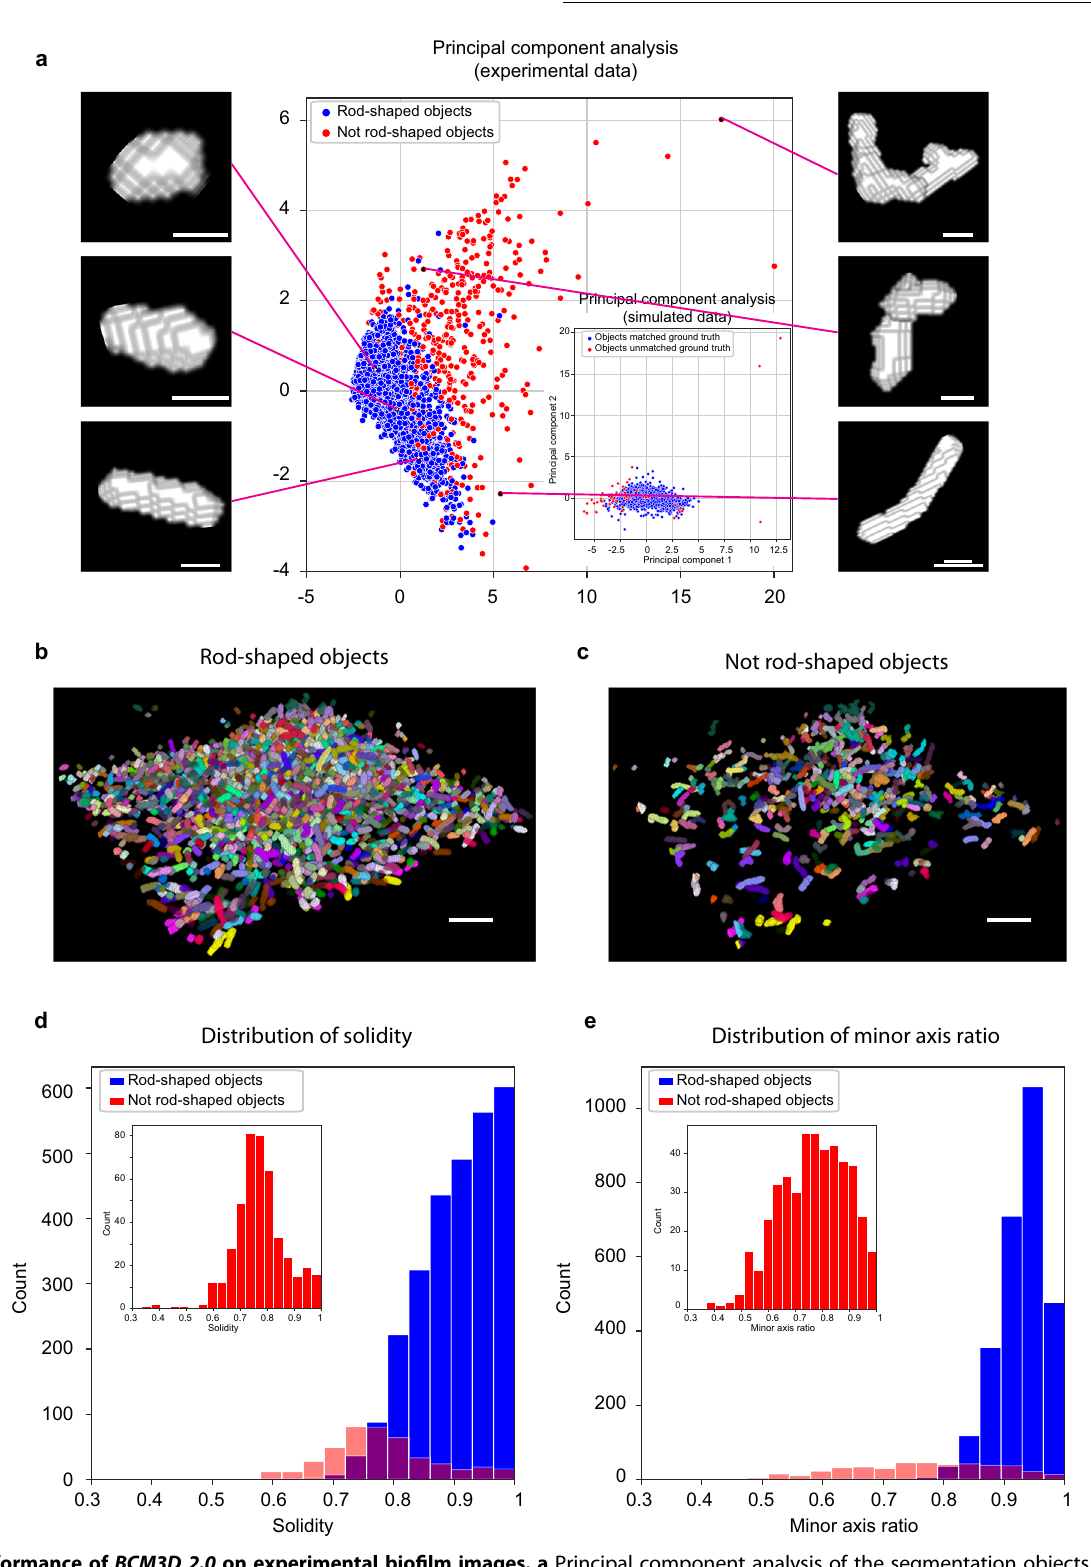
Fig. 2 Performance of BCM3D 2.0 on experimental bio fi lm images. a Principal component analysis of the segmentation objects (obtained from experimentally acquired images) that were classi fi ed by a pre-trained 3D CNN as either physiologically reasonable rod-shaped cells or oddly shaped (not-rod-shaped) cells. Three examples cell shapes of each class are shown to the right and left, respectively. Inset: same analysis on simulated bio fi lm images. Scale bars are 0.6 µm. b 3D segmentation results for objects classi fi ed as physiologically reasonable rod-shaped cells. Scale bar is 5 µm. c 3D segmentation results for objects classi fi ed as oddly shaped. Scale bar is 5 µm. d , e Comparison of the solidity and minor axis ratio distributions of rod-shaped and oddly shaped